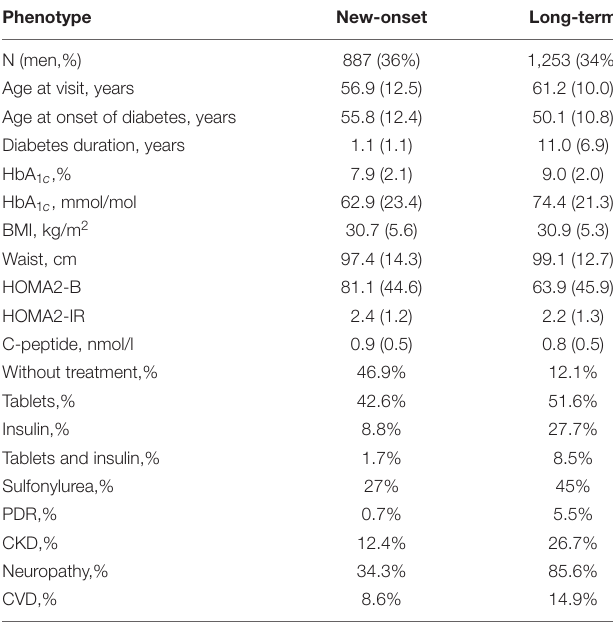
TABLE 1 | Clinical characteristics of patients with adult diabetes in the DOLCE